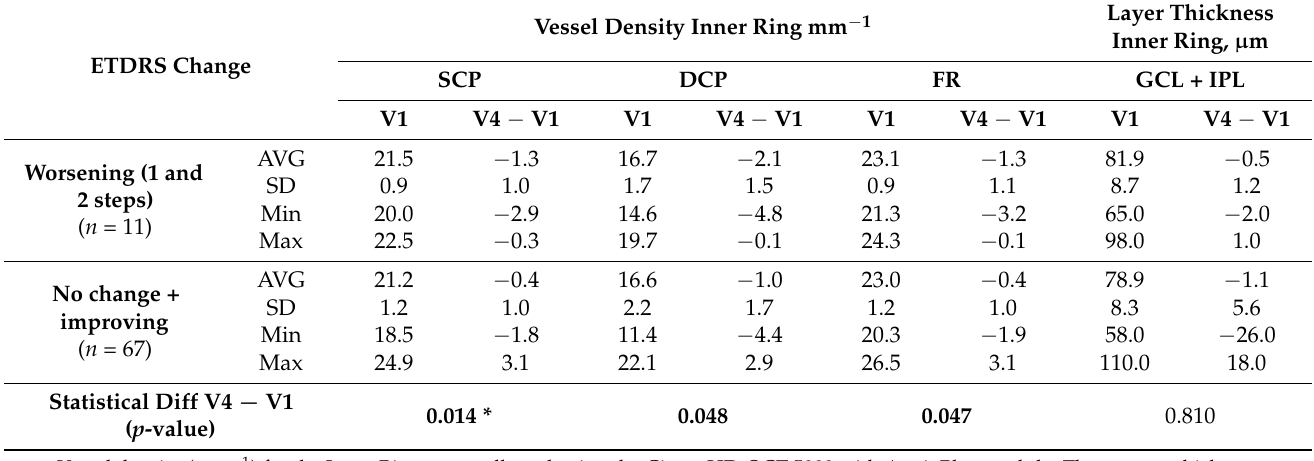
Vessel density (mm − 1 ) for the Inner Ring were collected using the Cirrus HD-OCT 5000 with AngioPlex module. The average thickness values at the inner ring of the GCL + IPL were collected from Zeiss Cirrus standard reports. Comparison was performed by Mann–Whitney U-test, followed by Bonferroni correction for multiple comparisons. Significant p -values ( p < 0.005) are highlighted in bold. * indicates a significance level of 0.017 obtained after Bonferroni correction. AVG: Average; SD: Standard deviation; Min: Minimum value; Max: Maximum value; SCP: Superficial capillary plexus; DCP: Deep capillary plexus; FR: Full retina; GCL + IPL: Ganglion cell + Inner plexiform layers. V1: Baseline visit; V4: Last visit (3